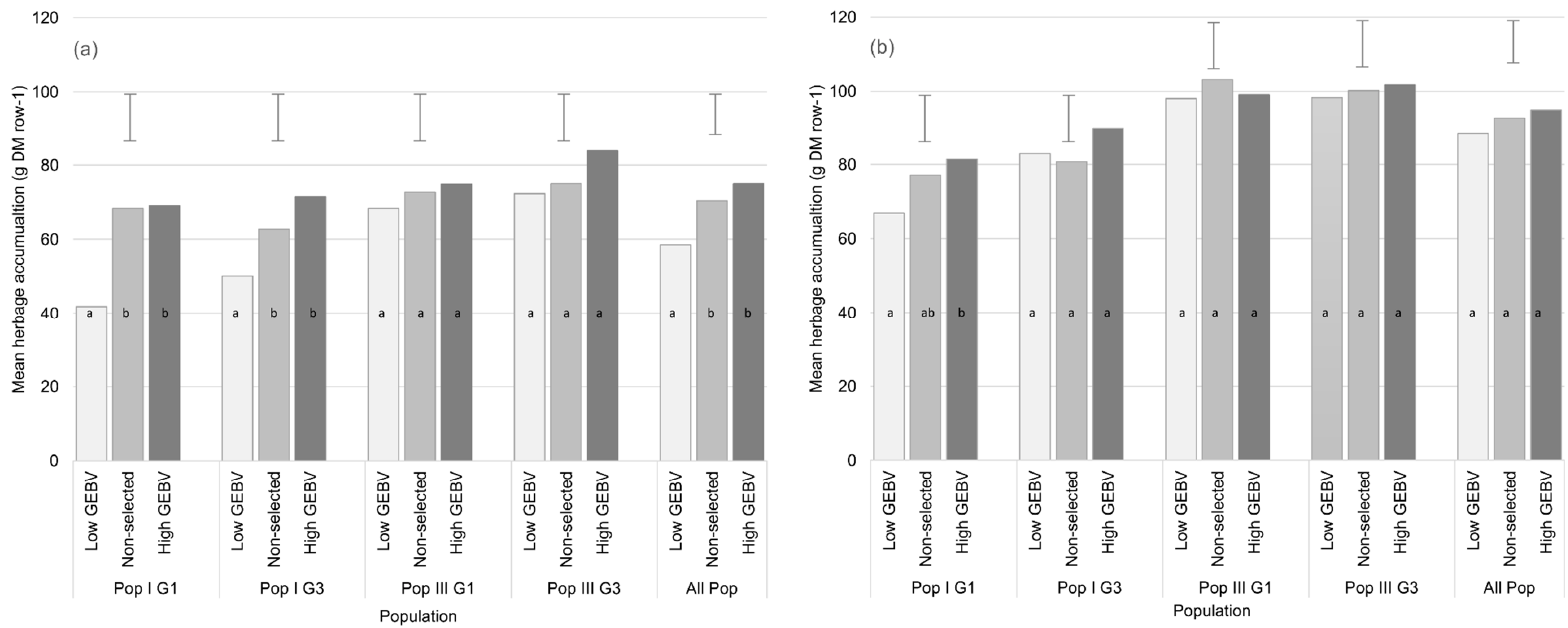
Figure 3. Herbage accumulation measured as dry matter yield per plot, for Low GEBV, High GEBV, and Non-selected selection group (SG) progenies generated by genomic selection from four populations (Pop I G1, Pop I G3, Pop III G1, and Pop III G3), and combined across all populations (All pop). Data are BLUEs for performance at ( a ) Waikato (from n = 7 seasonal harvests) and ( b ) Manawatu (from n = 8 seasonal harvests). Within each population, SG bars with different letters are significantly different ( p < 0.05), as supported by least significant difference (L.S.D 0.05 ) error bars.